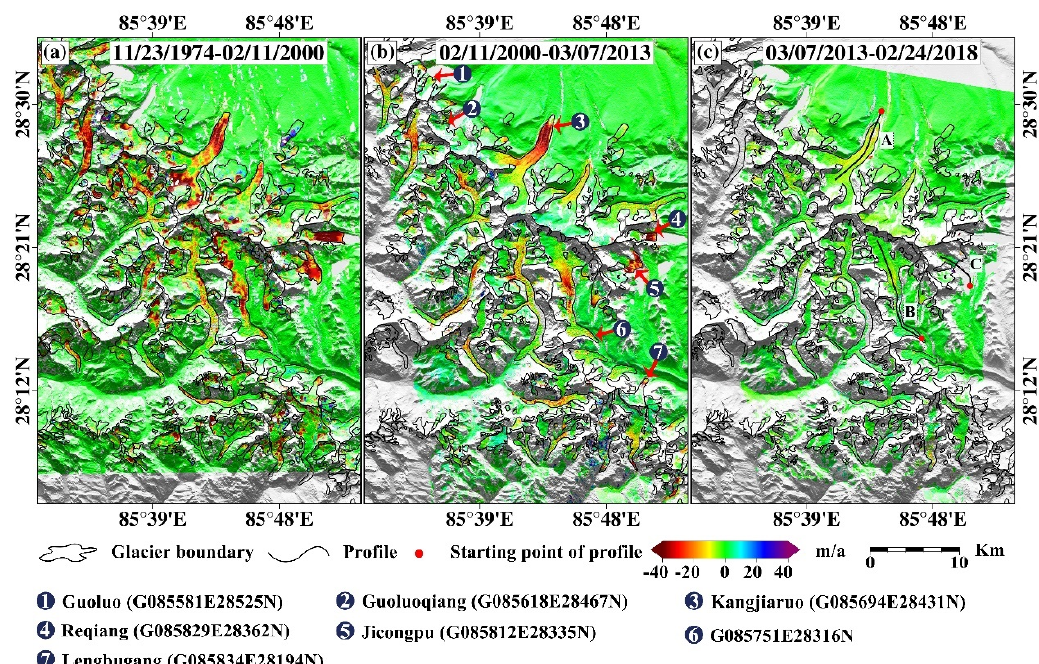
Figure 8. Changes in glacier thickness in the Xixabangma massif during different periods: ( a ) 02/2000–11/1974 (SRTM-C DEM minus KH-9 DEM); ( b ) 03/2013–02/2000 (TanDEM-X DEM minus SRTM-C DEM); ( c ) 02/2018–03/2013 (TanDEM-X DEM minus TanDEM-X DEM). Backgrounds are the shaded SRTM-C DEM. Glacier thickness changes along profiles A, B and C are shown in Figure 9. The red dots denote the starting points of profiles.